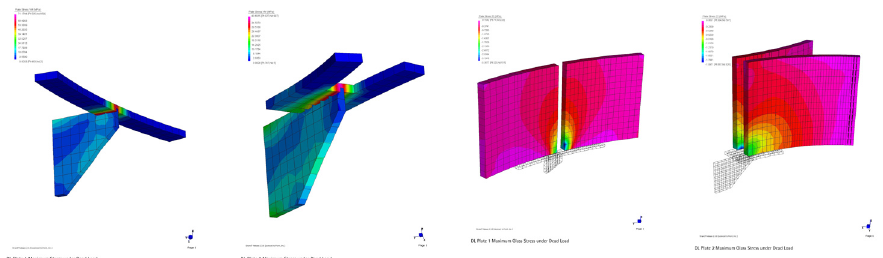
Figure 21a, b, c, d: Finite Element Analysis of Dead-load Support Cleats and Resultant Stresses in Glass. The glass panels are supported by two-side structural silicone pre-bonded to aluminum glazing channels. The horizontal joints are frameless with glass panels being supported on custom engineered steel and EPDM bearing shelves, supported in turn directly off the mullion. These elements were profiled so that they followed the curvature of the glass at every location allowing them to be embedded in and concealed by the silicone sealant between